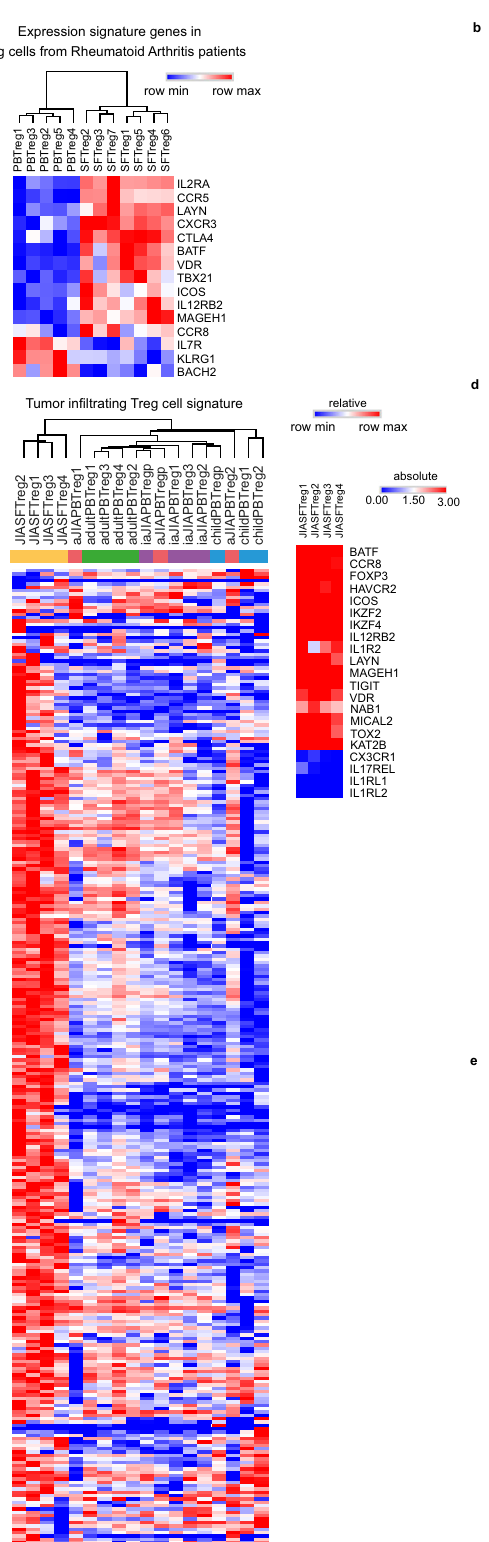
Aria III (BD). Antibodies used for sorting are: anti-human CD3-BV510 (clone